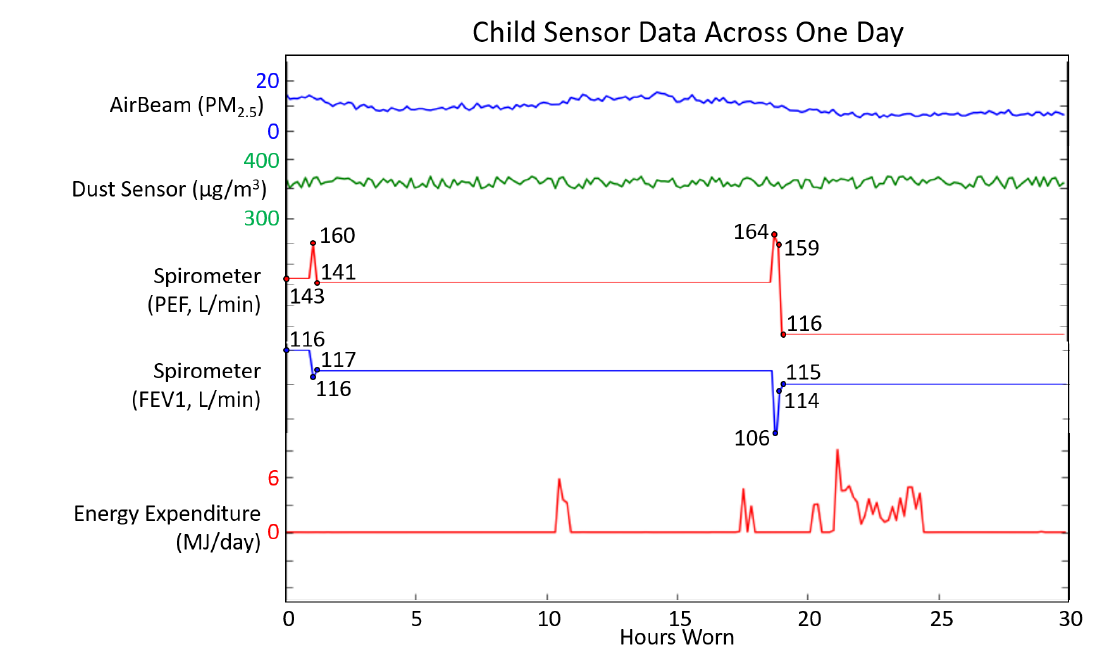
Figure 6. Data from select sensors during the child’s usability testing across one day of use. Spirometer values are displayed, along with sensor